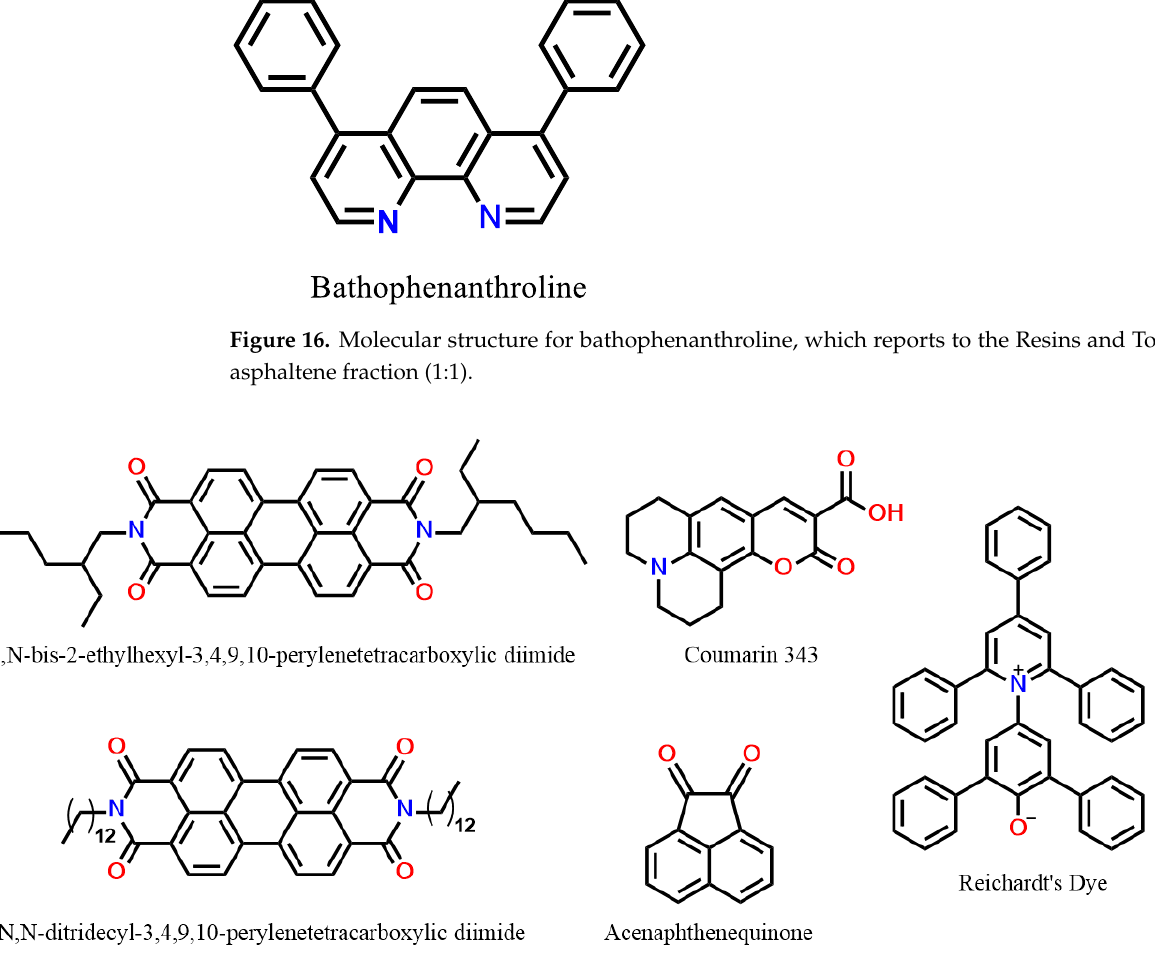
Figure 17. Molecular structure for model compounds acenaphthenequinone (MW = 182.17 Daltons); Coumarin 343 (MW = 285.29 Daltons); N,N-bis-2-ethylhexyl-3,4,9,10-perylenetetracarboxylic diimide (MW = 614.79 Daltons); and N,N-ditridecyl-3,4,9,10-perylenetetracarboxylic diimide (MW = 755.06 Daltons). Reichardt’s dye reports to the CH2Cl2 asphaltenes, while the other molecules elute to the Toluene asphaltenes.